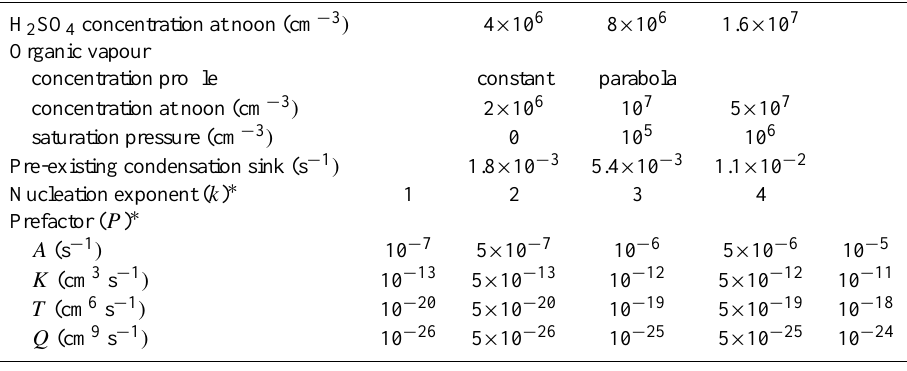
Table 1. Parameters used in the model